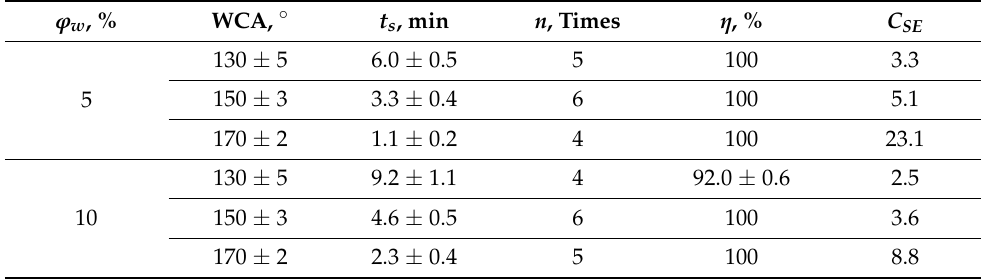
Table 2. Efficiency coefficient for the separation of emulsions with different water concentrations for different contact angles of a hydrophobic